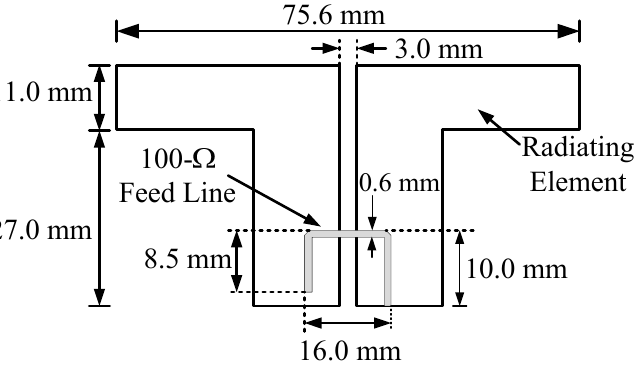
Figure 2. Dimensions of the optimally designed single element.